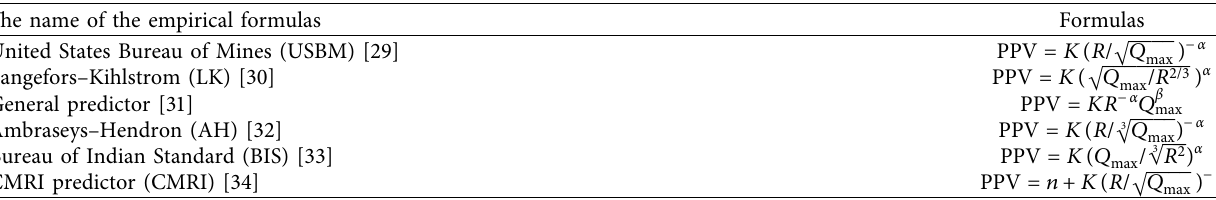
Table 2: Conventional empirical formulas for blasting prediction.